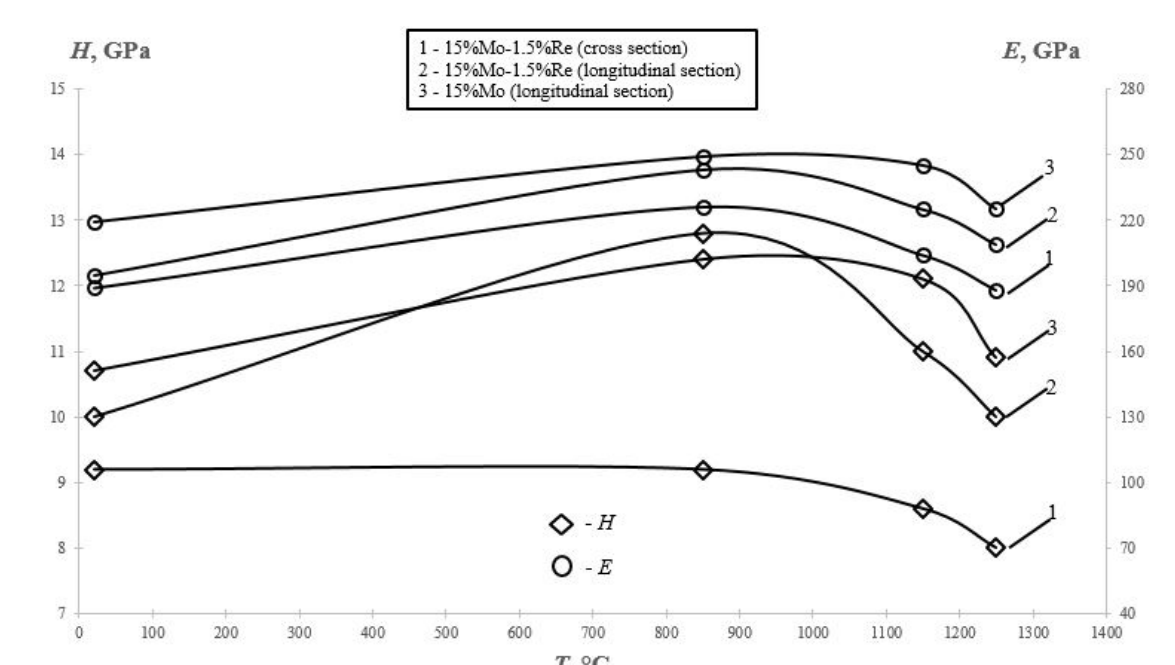
Figure 14. Mechanical properties of the NiAl–Cr–Co+15%Mo and NiAl–Cr–Co+15%Mo–1.5% Re alloy samples (in the longitudinal and transverse cross-sections) as a function of the annealing temperature according to the instrumented indentation data. Figure 15 shows the microstructures of the NiAl–Cr–Co+15%Mo alloy before (a) and after annealing at 1150 °C (b) and 1250 °C (c).